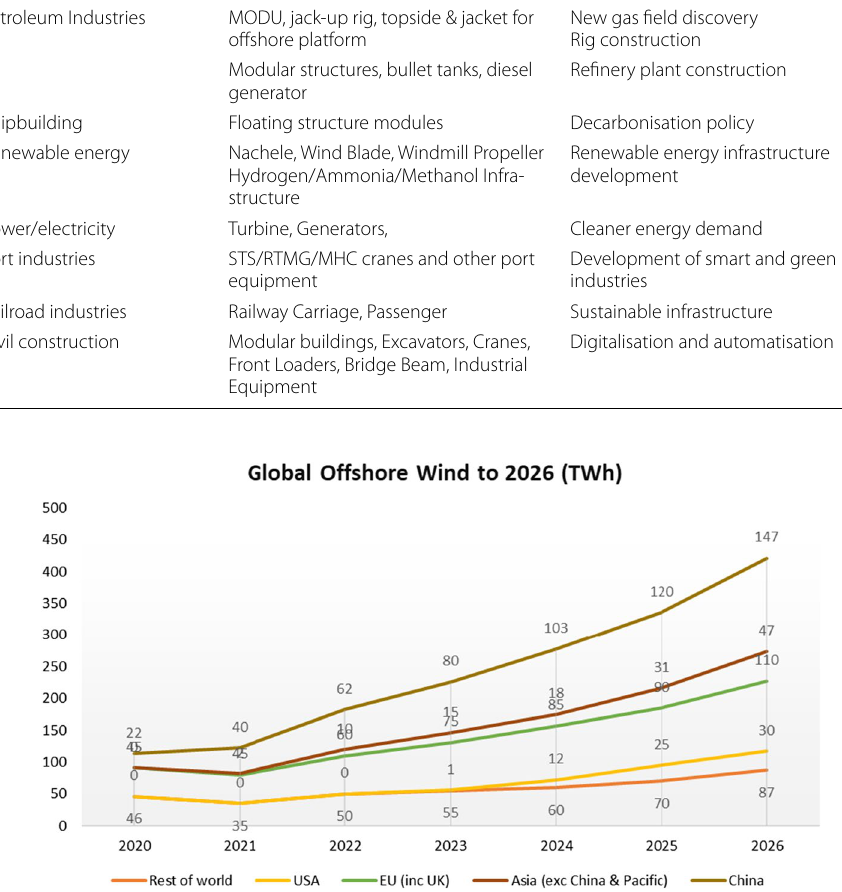
Table 1 Project cargo categories: outbound products Industry type (Pi and Club. Carefully to Carry. 2018)